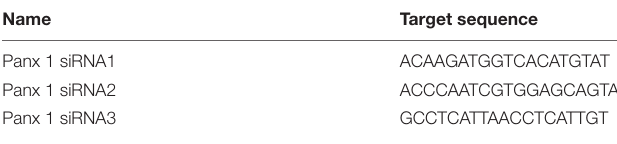
TABLE 2 | Panx 1-targeting siRNA sequences. Name Target